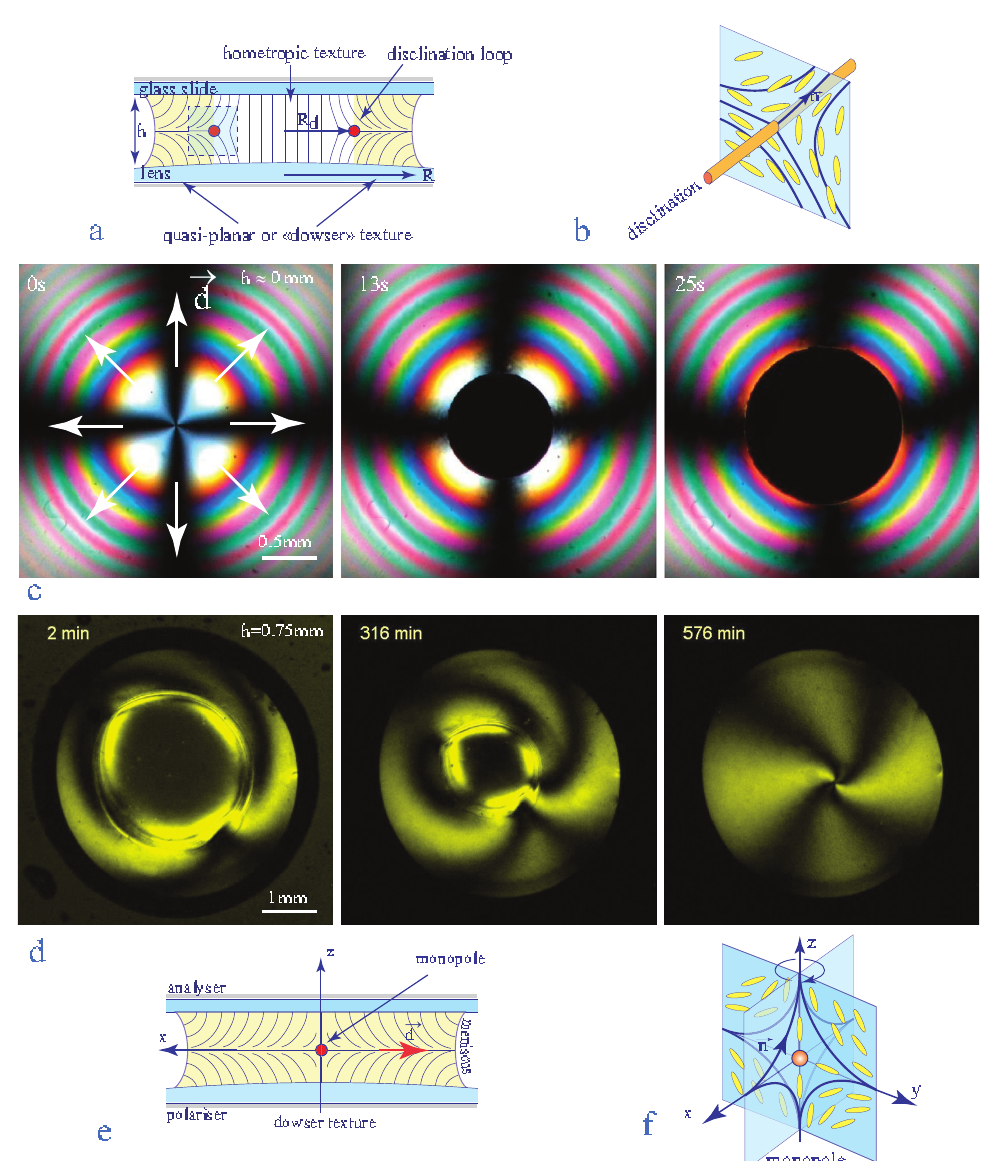
Figure 5. Metastability of the dowser texture. ( a ) Coexistence of the dowser and homeotropic textures.